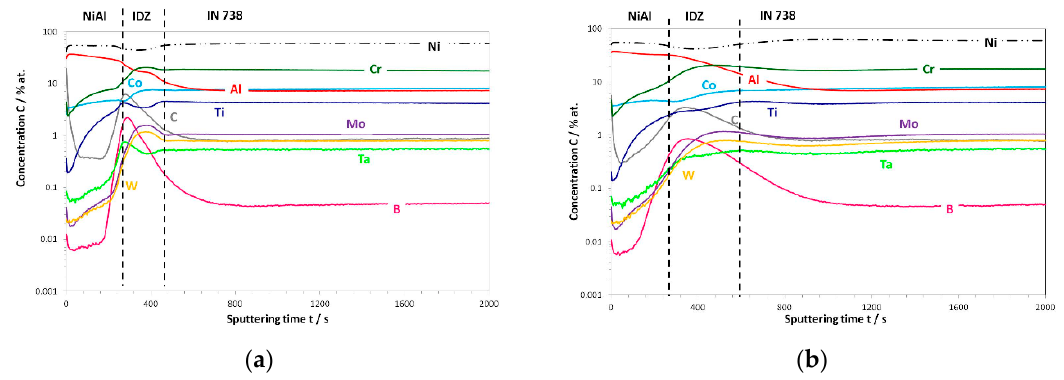
Figure 8. The GD-OES depth profile for aluminide layer formed on: ( a ) Ground and ( b ) grit-blasted IN 738 in the as-received condition.